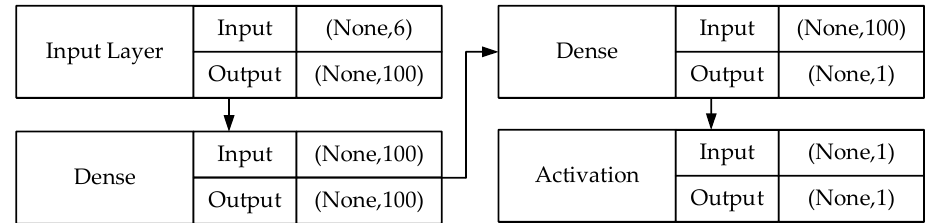
Figure 8. The overall architecture of the neural network.